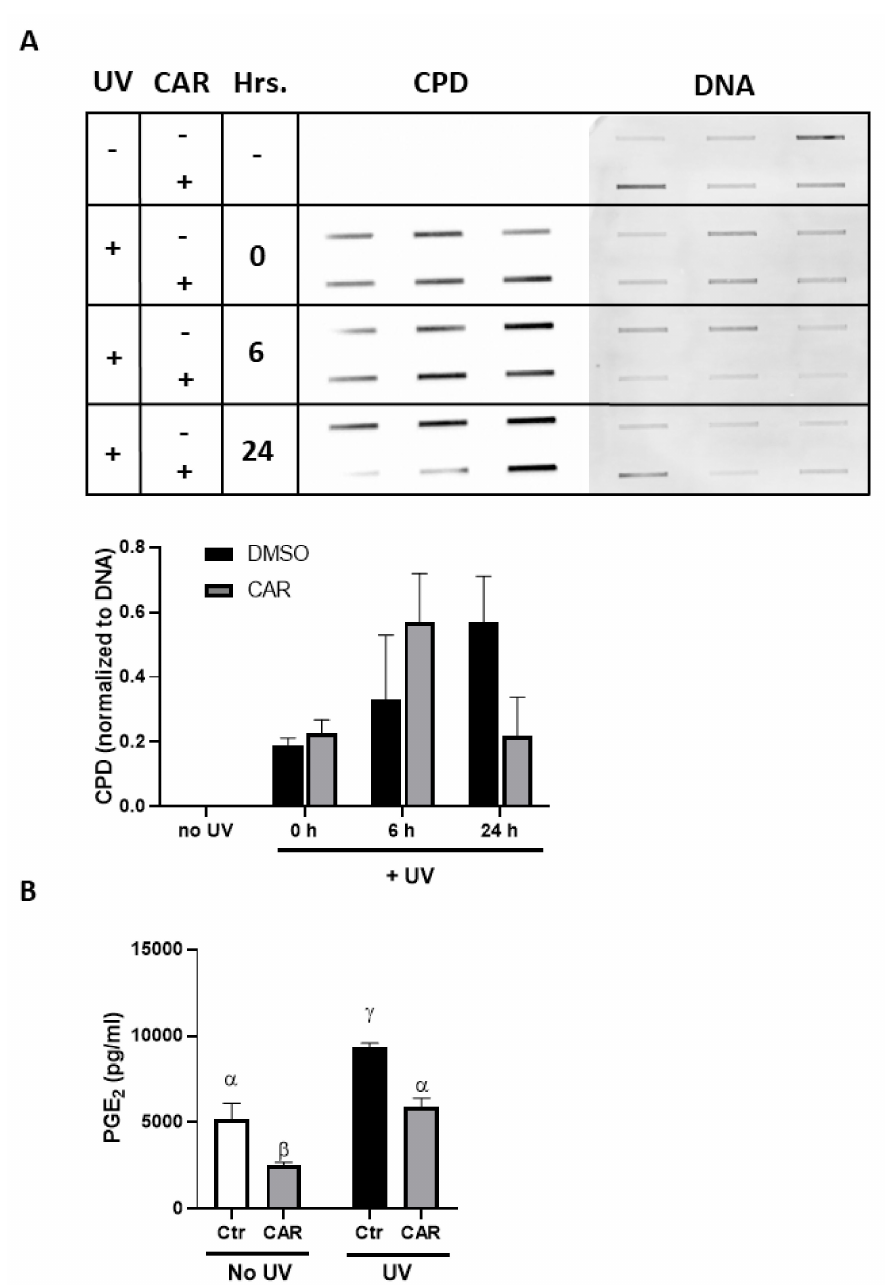
Figure 3. E ff ect of carvedilol on UV-induced CPD formation and PGE 2 secretion in JB6 P + cells. ( A ) The slot blot assay of CPD. Genomic DNA was isolated from the cultures irradiated with 25 mJ / cm 2 UV and pretreated for 2 h and immediately post-UV treated with 5 µ M carvedilol; the cells were harvested immediately (0 h), 6, or 24 h after UV exposure. CPD production was quantified and normalized by SYBR TM Gold staining of the DNA. Each band represents a DNA sample from one cell culture from each treatment group. ( B ) PGE 2 levels determined by enzyme-linked immunosorbent assay (ELISA) in culture media from untreated or UV-irradiated JB6 culture treated with dimethyl sulfoxide (DMSO, the vehicle) or carvedilol (5 µ M). Data are presented as the means ± SE ( n = 3). The bars with a di ff erent letter are significantly di ff erent from each other at the level of P <